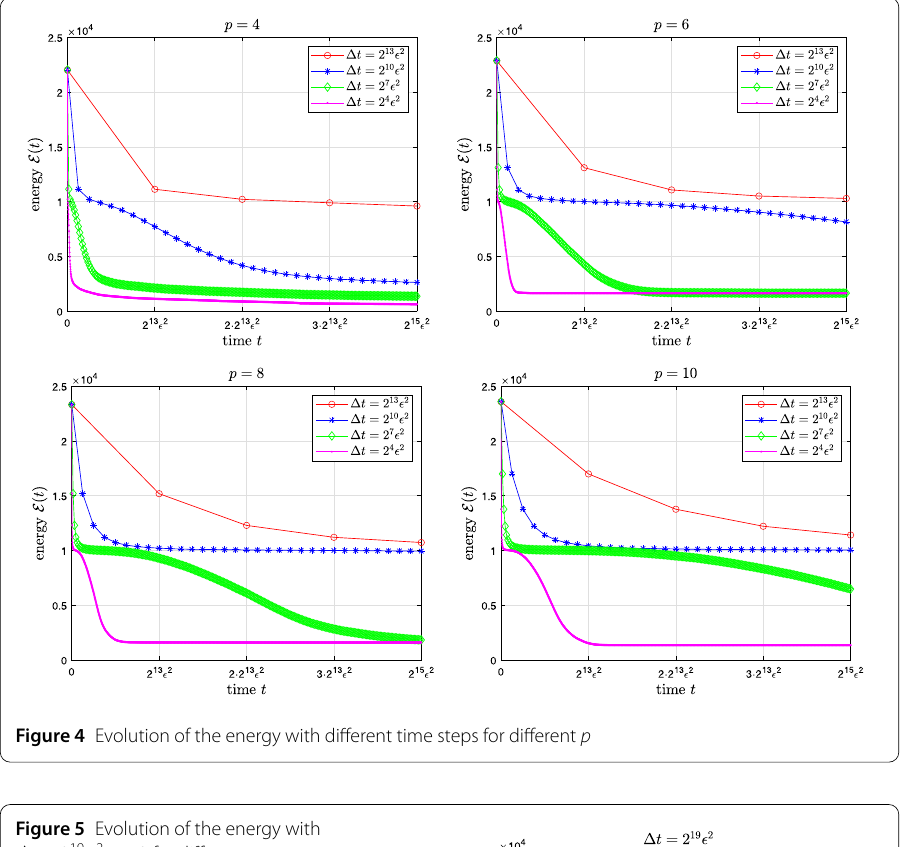
Figure 5 Evolution of the energy with (cid:7) t = 2 19 (cid:4) 2 ≈ 13 for different